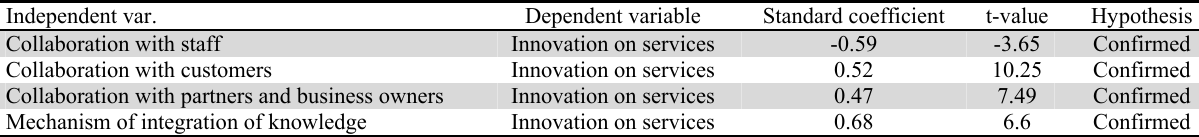
The summary of SEM